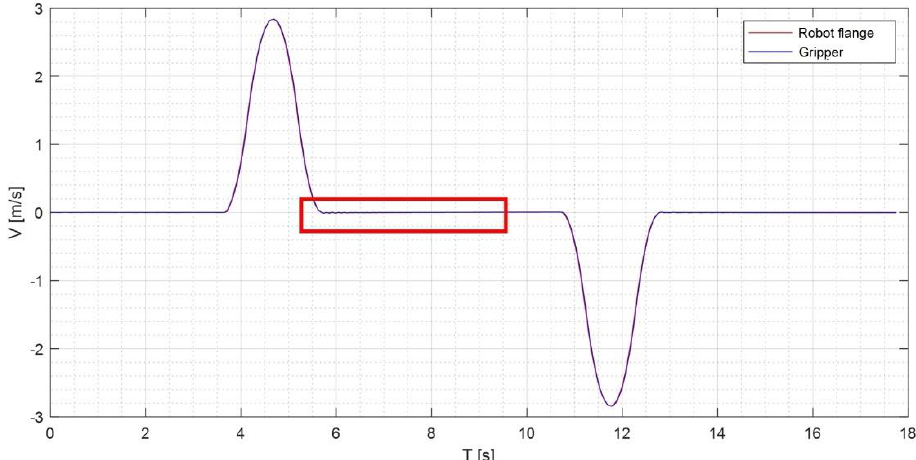
Figure 18. Velocity graphs calculated from data recorded by MTi XSENS mounted at the robot flange and on the gripper for parameters V4000 and ACC100.